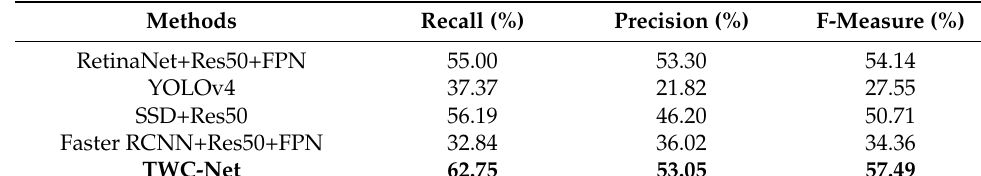
Table 3. Recall, precision, and F-measure of all methods (IOU = 0.75).